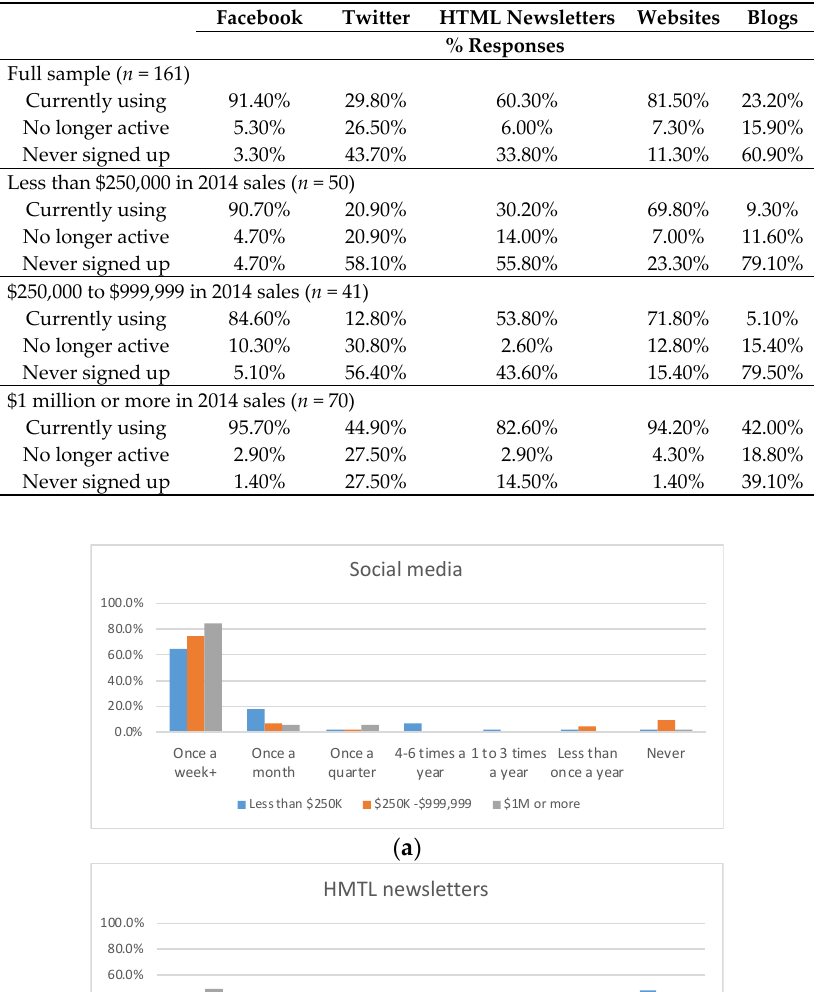
Table 5. Status of online platform accounts of ornamental horticulture industry respondents in the study questionnaire.